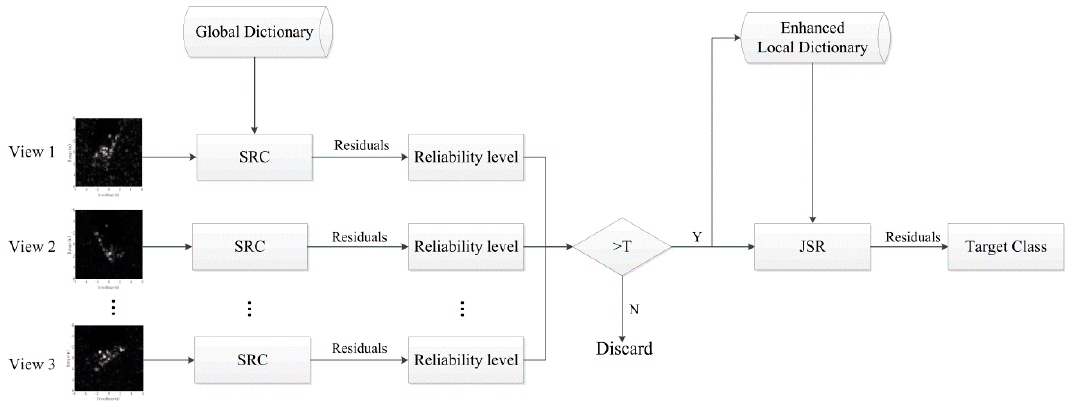
Figure 4. The framework of the proposed method. SRC: sparse representation-based classification; JSR: joint sparse representation.